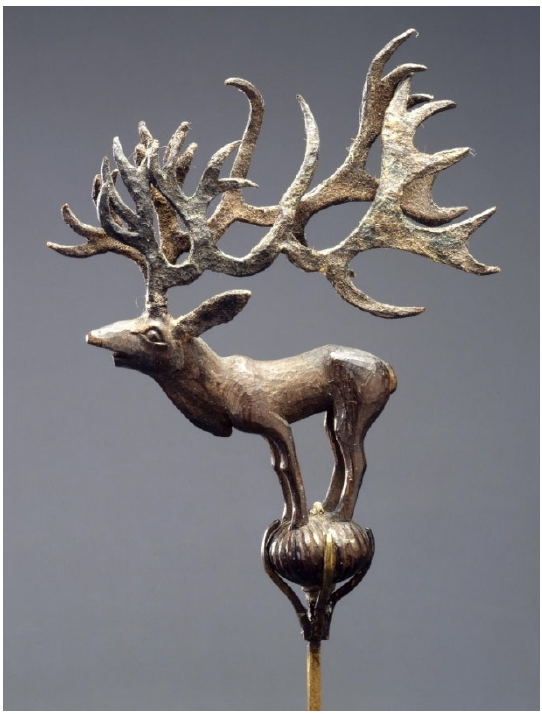
Figure 6. Pin finial in the form of a stag (SHM inv. no. 1684 ‐ 154); leather, wood; Kurgan 2, Pazyryk, Altai mountains, Russia; late 4th to early 3rd century BC. [Image is used from